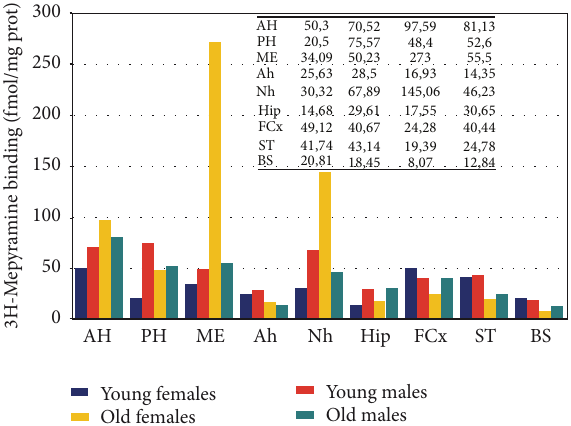
Figure 1: Age- and sex-related changes in brain histamine H1 recep- tors. AH: Anterior Hypothalamus; PH: Posterior Hypothalamus; ME: Median Eminence; Ah: Adenohypophysis; Nh: Neurohypoph- ysis; Hip: Hippocampus; FCx: Frontal Cortex; ST: Striatum; BS: Brain Stem. Young rats < 3 months. Old rats > 12 months of age.